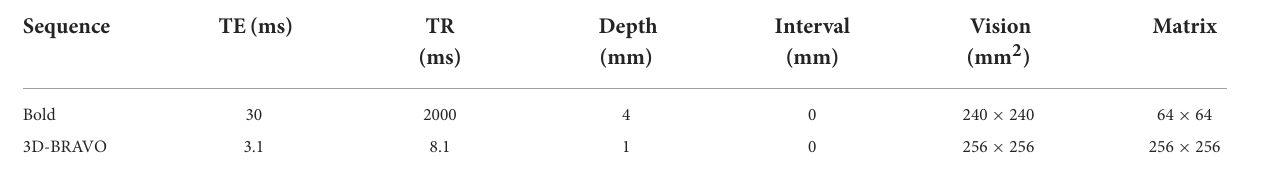
TABLE 3 Scanning